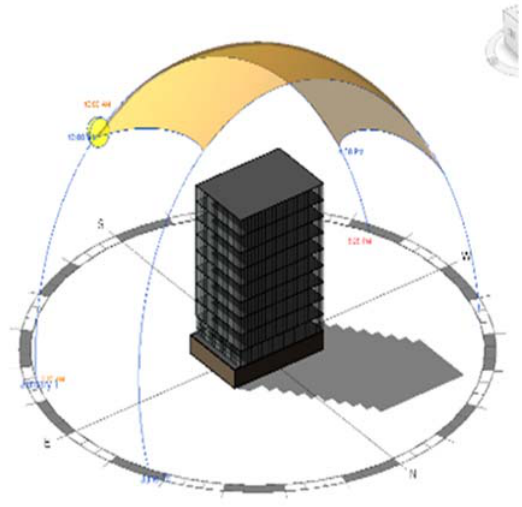
Figure 4. A Simulation model of building energy. Table 4. Geographic and climatic data at the building location.